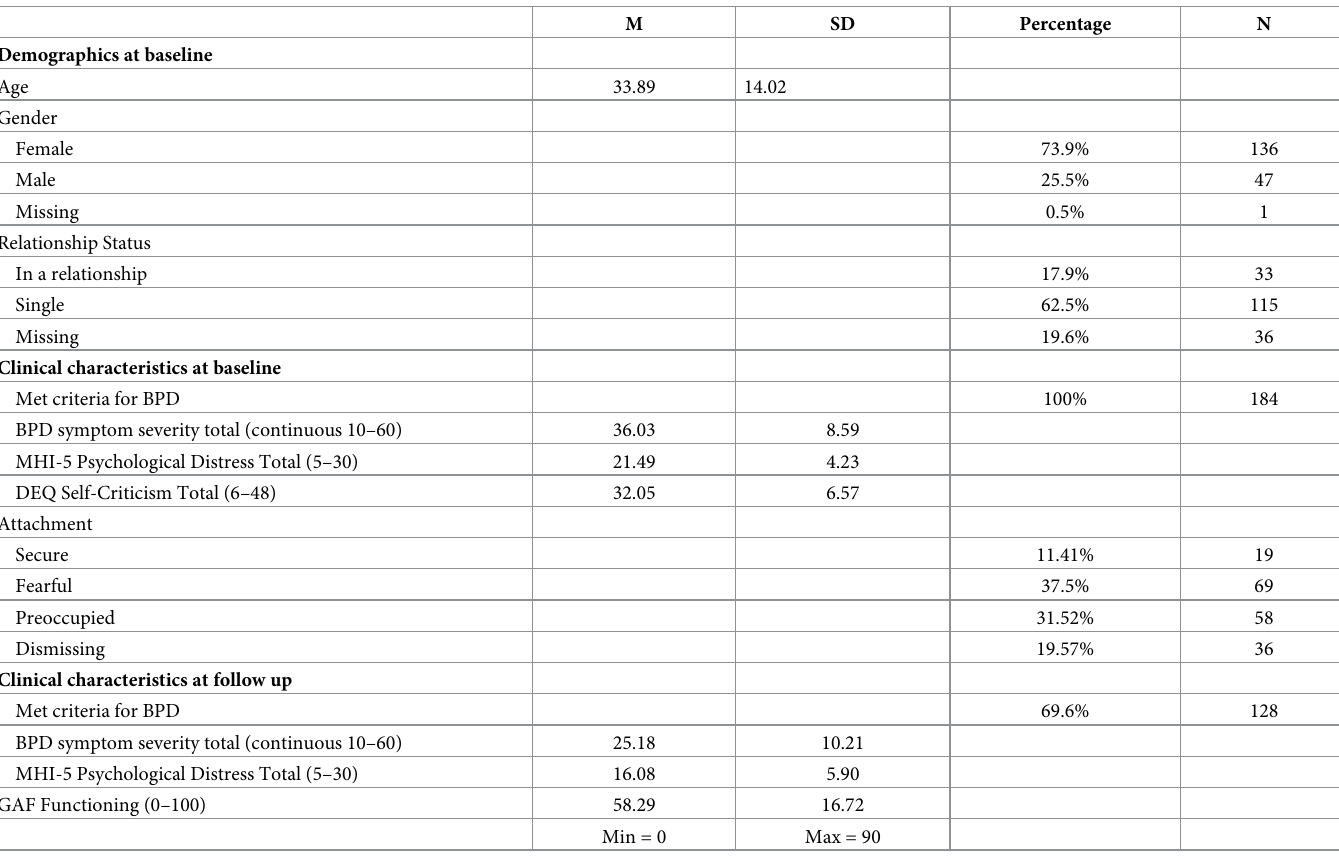
Table 2. Sample characteristics of people with Borderline Personality Disorder (N = 184) followed up for 12-months. M SD